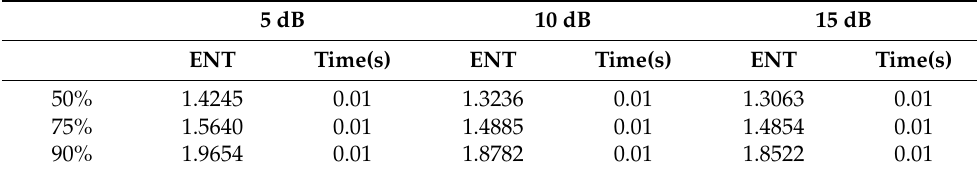
Figure 9. ISAR images of measured data with different loss rates and different SNRs. Table 10. Performance evaluation for the measured data with different loss rates under different SNR conditions.